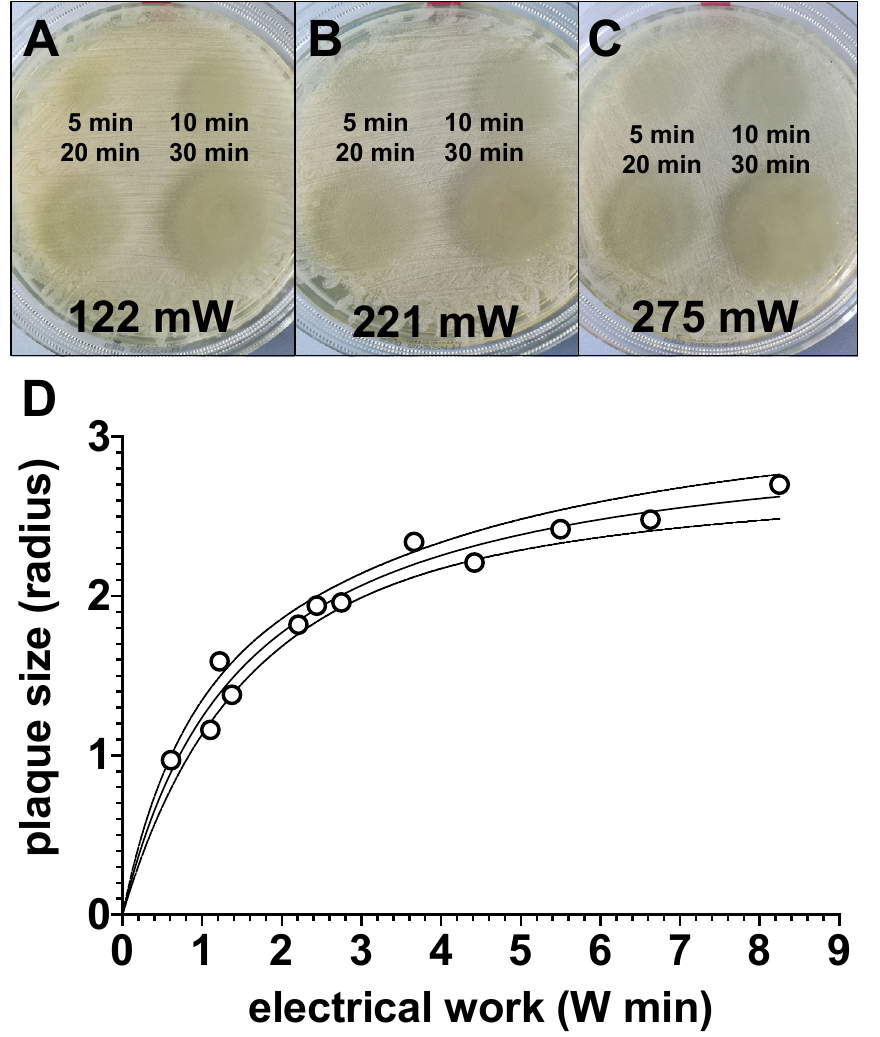
Figure 7. Evaluation of the effect of preventive plasma treatment of bacterial growth agar plates prior to bacterial inoculation. Four quadrants of bacterial agar growth plates were treated with plasma, generated with the power dissipated in the discharge of 122 mW ( A ), 221 mW ( B ) or 275 mW ( C ), for 5 min (top left), 10 min (top right) 20 min (bottom left) or 30 min (bottom right). The used electrode had a total diameter of 10 mm. A total of 24 h after plasma exposure, agar plates were inoculated with bacteria. After a further 24 h, the radii of the bacteria-free areas, as shown in ( A – C ), were measured with a ruler and these values were plotted graphically in relation to the electrical work dissipated in the discharge ( D ). Values shown in ( D ) represent the mean of two individual experiments. The solid line represents the interpolations line; the area between the solid lines represents 95%-asymptotic confidence interval.